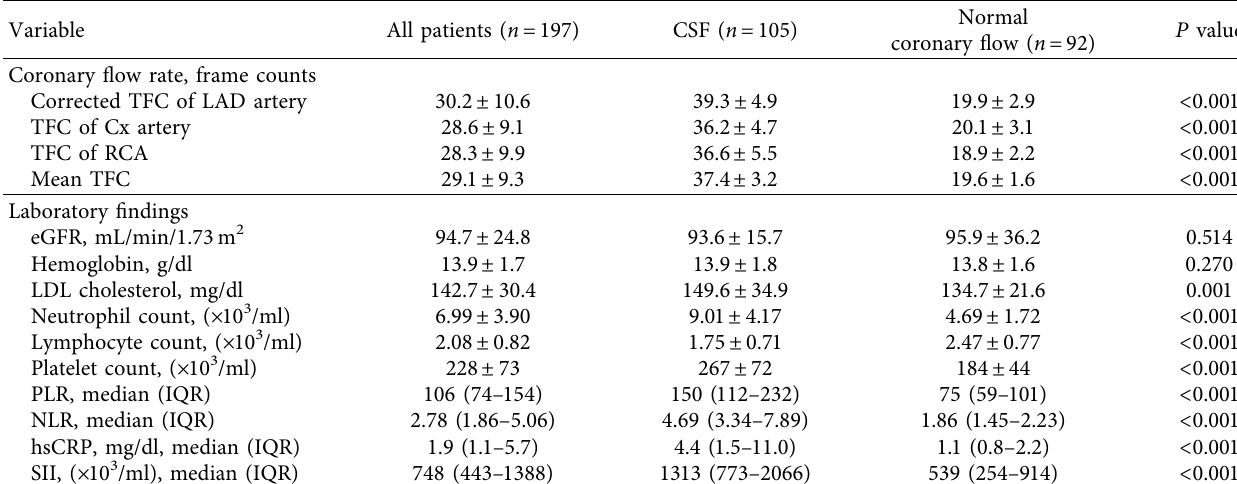
Table 2: Angiographic characteristics and laboratory results of the patients with coronary slow and normal coronary